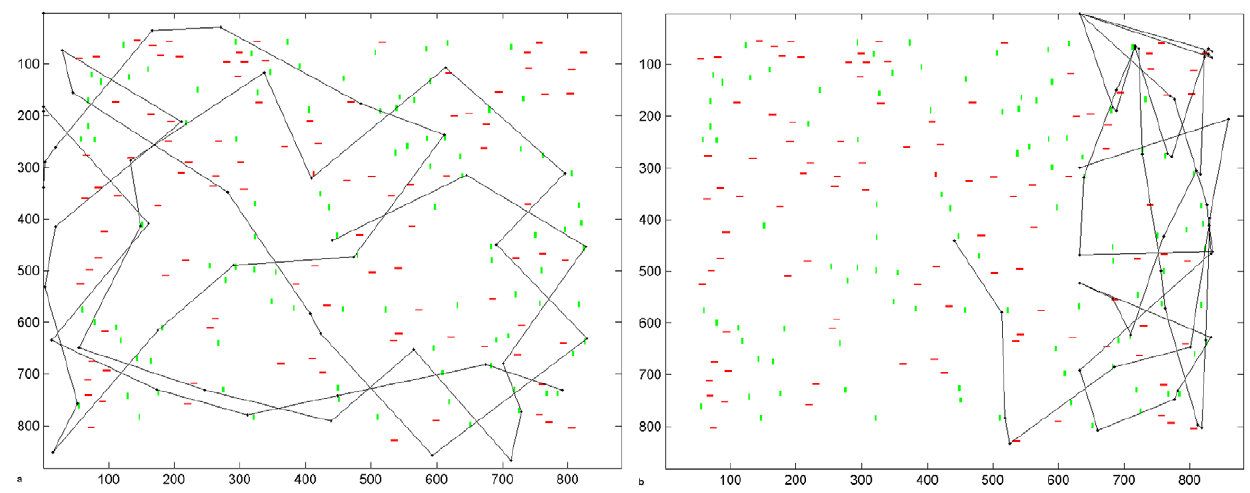
Figure 5. Effects of Spatial Compensatory Bias on Pathological Search Scanpaths. With the bias applied, the hemianopic scanpath is now able to search the blind hemifield (a). However, this bias fails to increase contralesional scanning in hemineglect (b). Axes refer to pixel position in the scene.